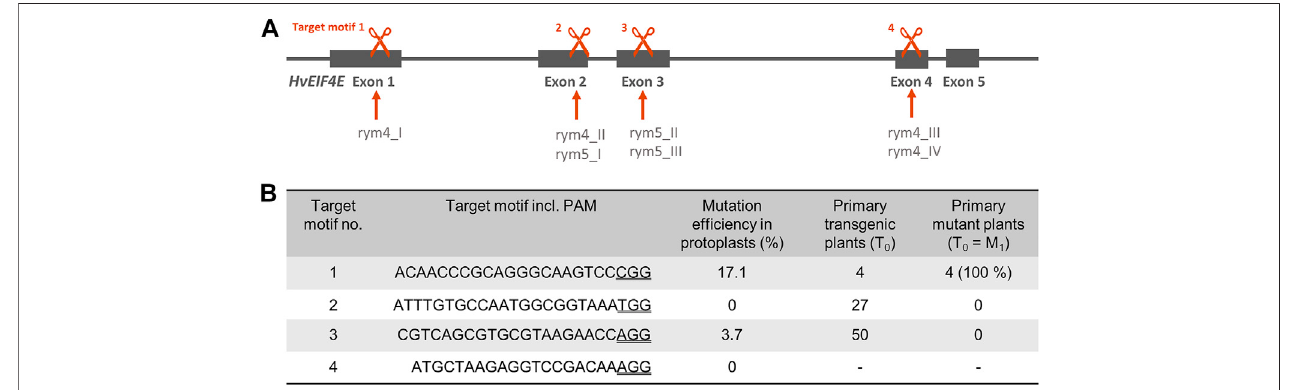
FIGURE 1 | (A) Gene structure of EIF4E , positions of previously described single nucleotide polymorphisms in rym4 and rym5 resistance alleles and positions of Cas9/gRNA target motifs for site-directed mutagenesis in Hordeum vulgare . Targets indicated by scissors symbols, genomic EIF4E sequence shown by grey line and exons by grey boxes. (B) Summary of target sequences, results of protoplast-based pre-validation of mutation ef fi ciency, number of regenerated plants upon Agrobacterium -mediated DNA transfer to embryogenic pollen cultures of winter barley cv. “ Igri ” , and mutant plants detected amongst transgenic